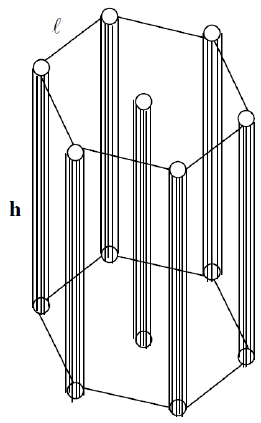
Figure 6. Hexagonal body-centered prismatic model.